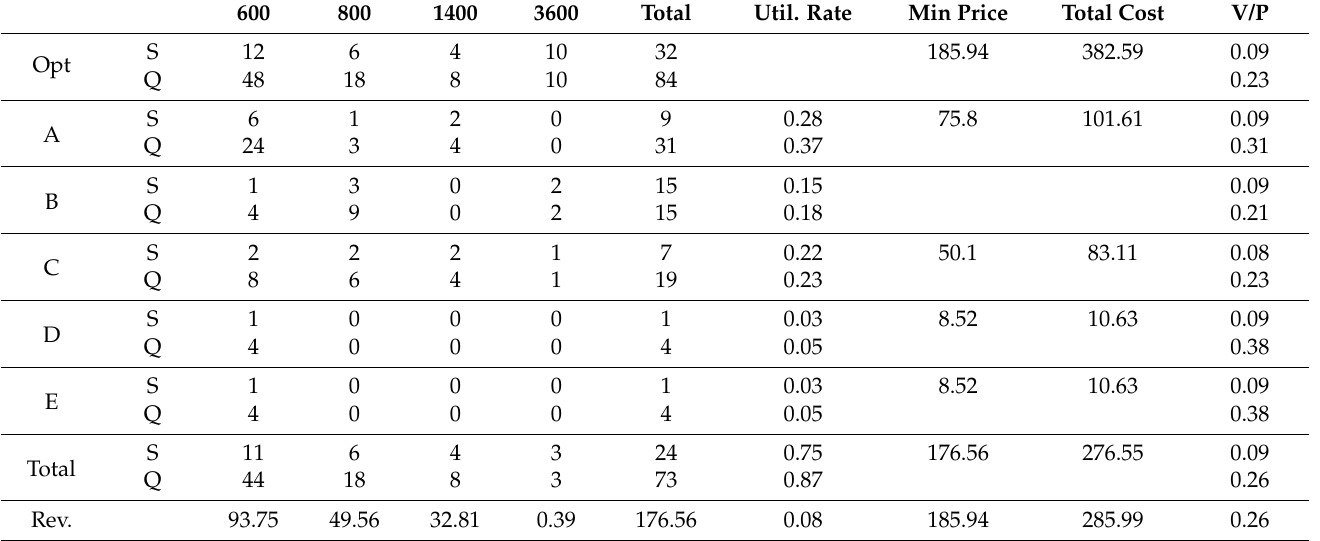
Table 10. Result of SA revenue and bidding RO.